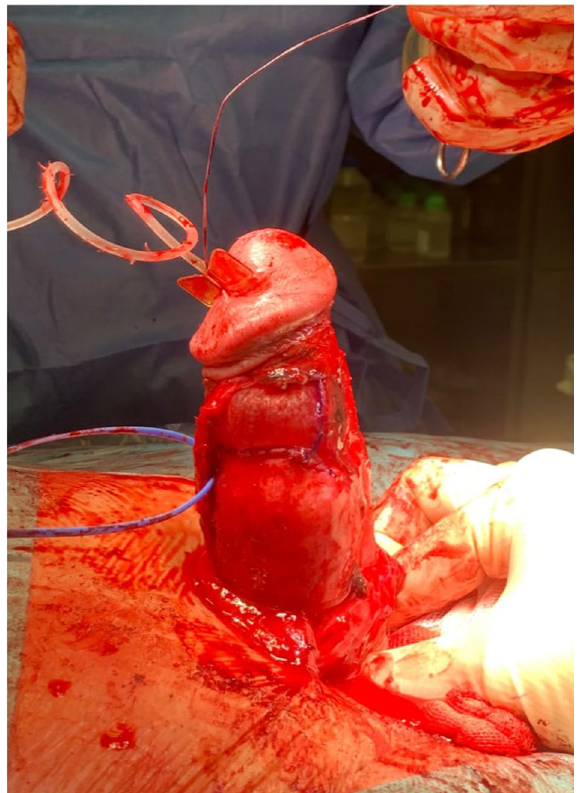
Figure 3. Application of penile grafting and fixation to the edges of the tunical defect with a 4-0 PDS running suture